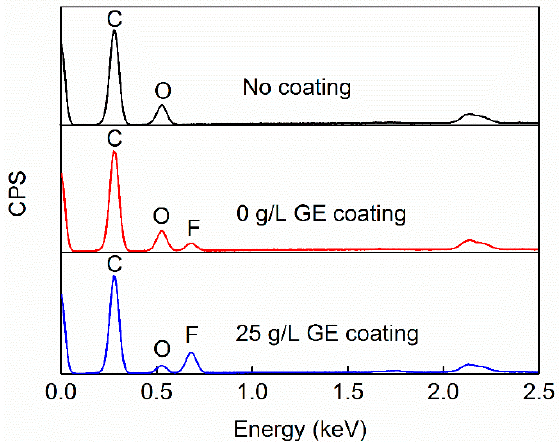
Figure 9. Photos of nonwoven and composites. ( a ) No coating; coating with ( b ) 0 and ( c ) 25 g/L GE.